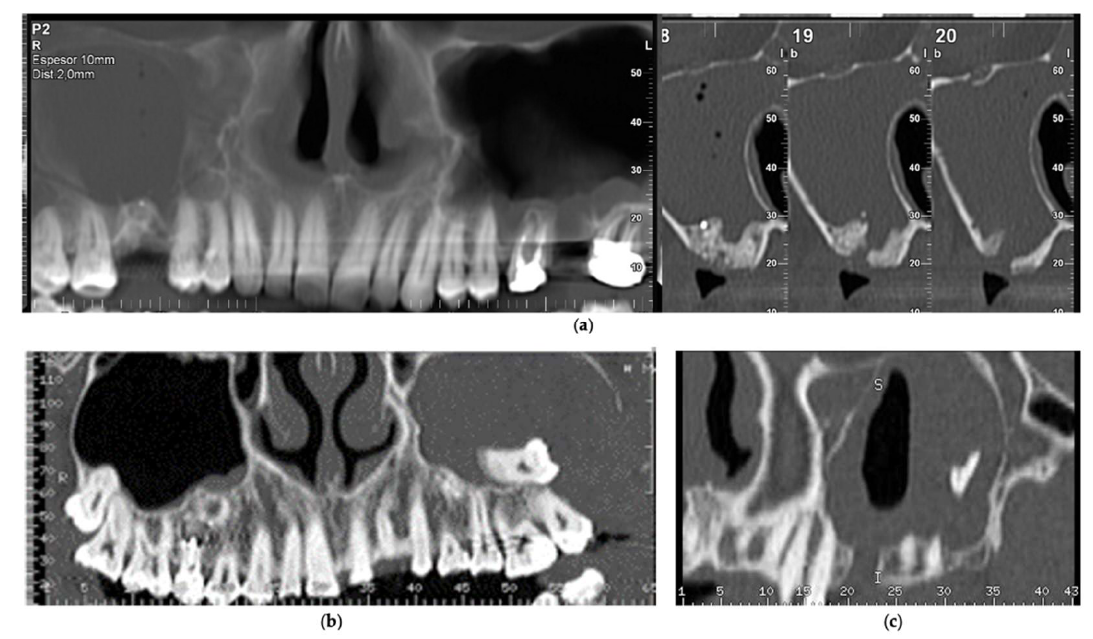
Figure 3. Oroantral communications triggering sinus thickening: ( a ) post-extraction communication of the upper right first molar; ( b ) displacement of the upper left third molar; ( c ) displacement of the tooth root to the left maxillary sinus.